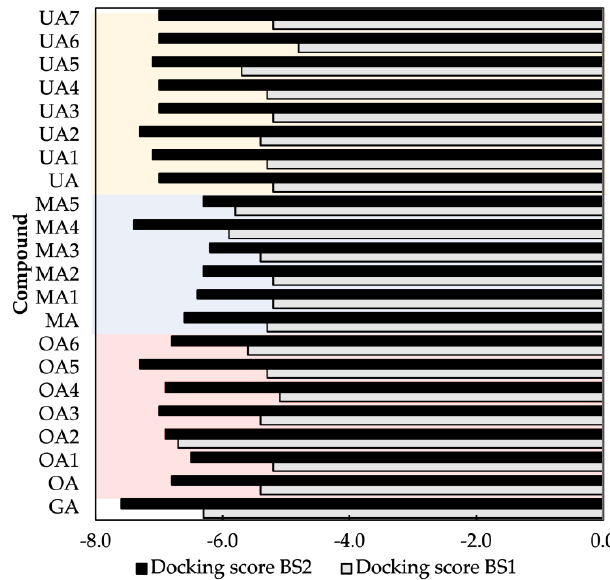
Figure 1. Autodock Vina docking scores for BS1 and BS2 sites for all the studied compounds. Docking scores are given in kcal/mol. Yellow, blue and red color boxes represent UA, MA and OA sets, respectively.